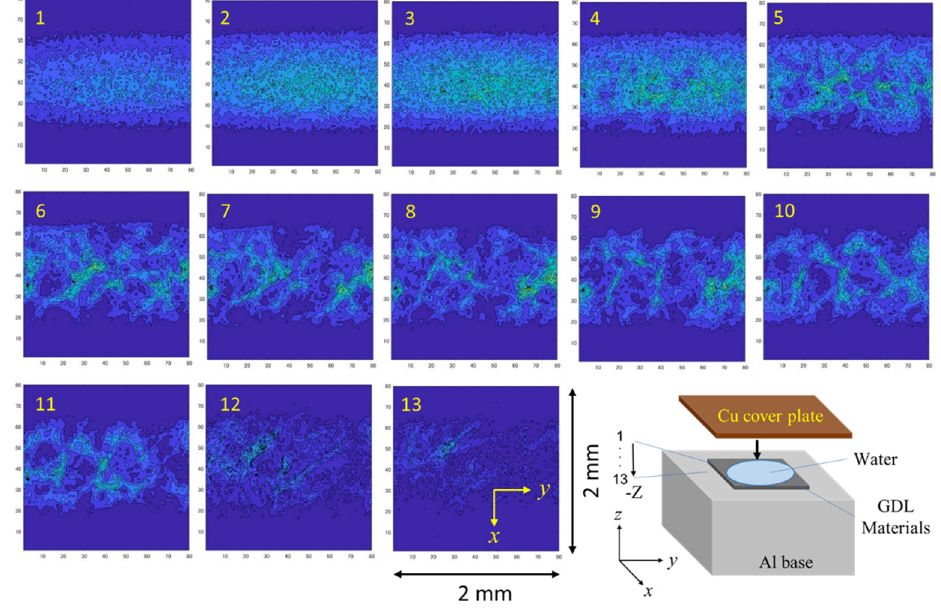
Figure 5. Cross-sectional images of wet GDL material. Incident X-rays come along the y direction and the Compton scattered X-rays toward the z direction are detected by a 2D X-ray detector through a 50 µ m pinhole.